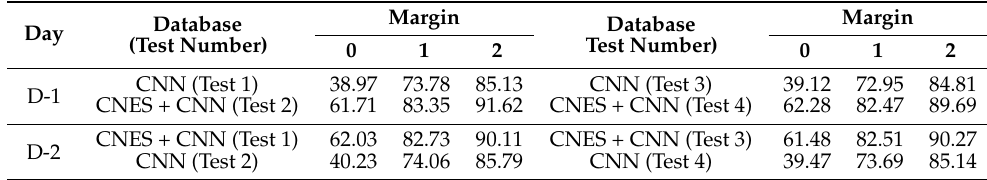
Table 7. Summary of real time testing of experimental